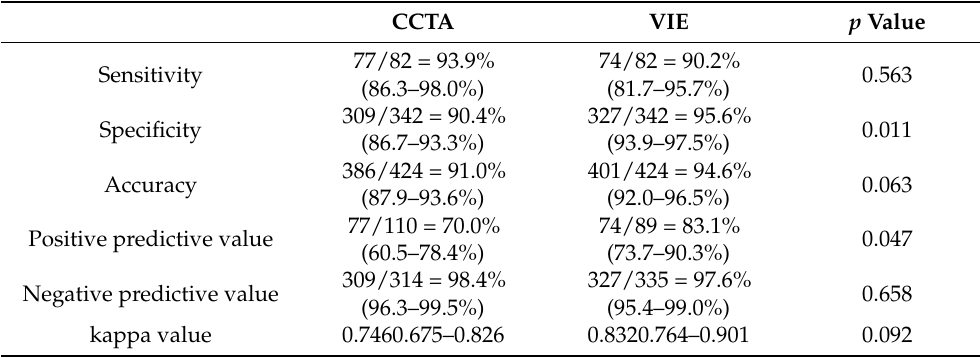
Table 6. Diagnostic performance of CCTA versus VIE in detecting coronary artery disease in 424 vessel segments with stents, CP, MP, or SP, using ICA as the gold